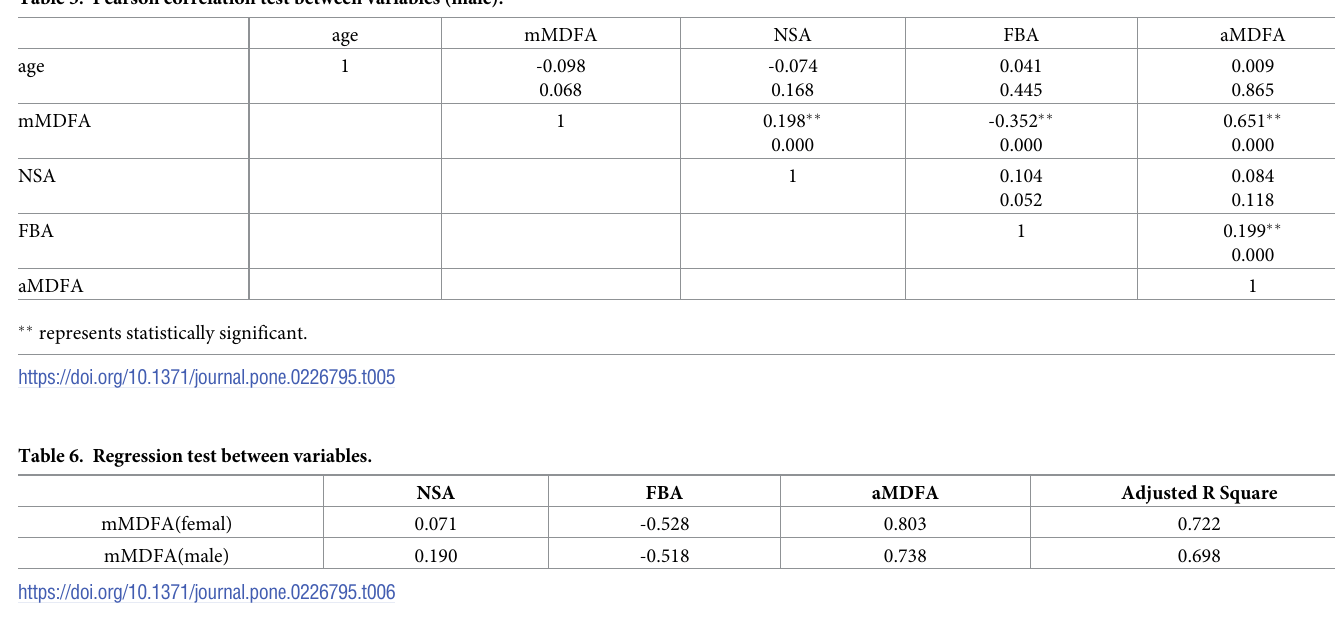
Table 5. Pearson correlation test between variables (male).